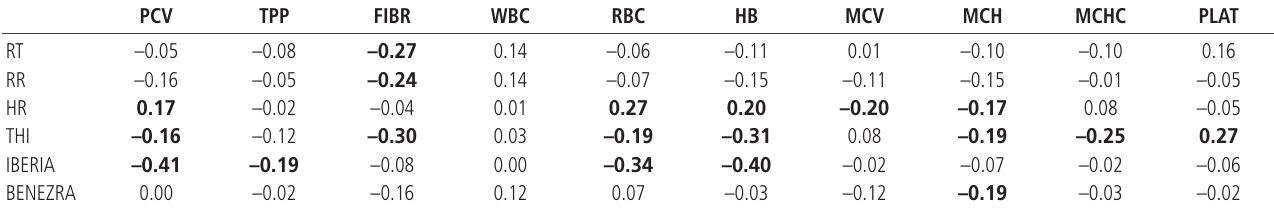
Table 8. Correlations between blood and physiological parameters and heat tolerance indices 1)